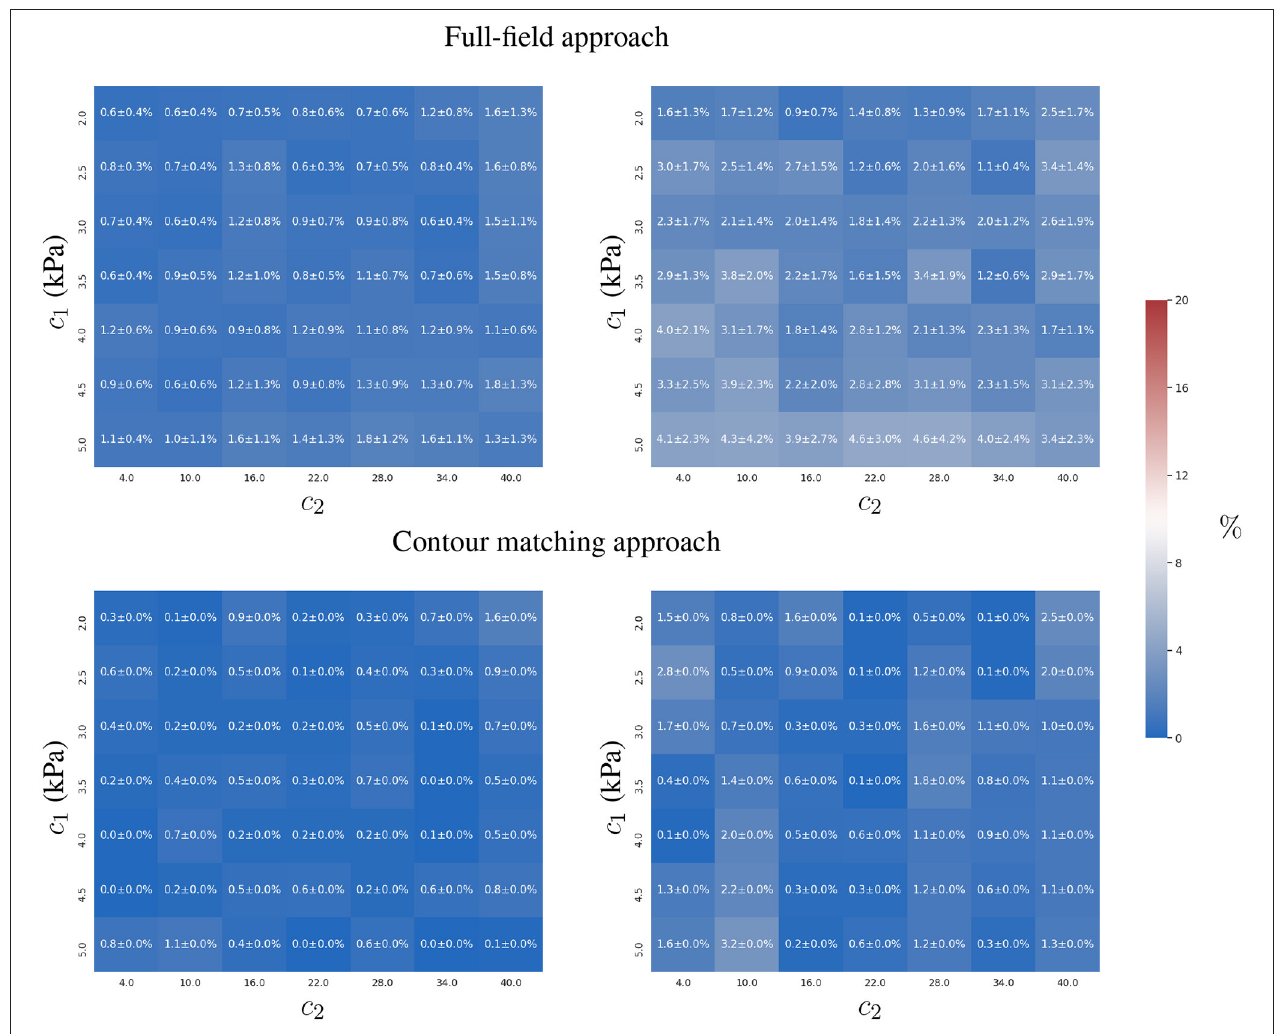
FIGURE 5 | Mean and standard deviation of the relative error for the two-parameter estimation of c 1 (left) and c 2 (right) constitutive parameters using full-field tracking and contour matching approaches, a pressure trace with 10 time-points, and independent Gaussian noise ( σ = 1mm ≈ 2 pixels) in the